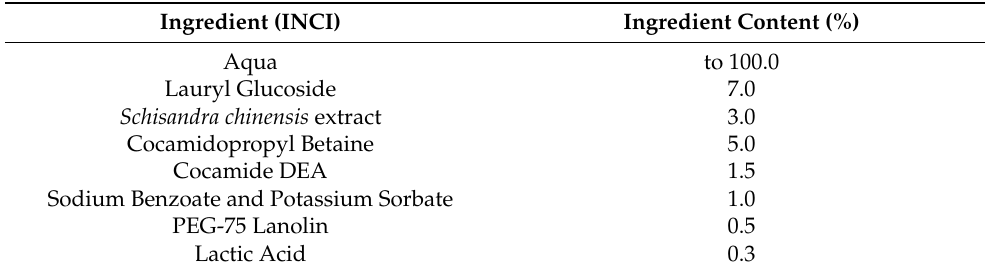
Table 4. Formulation of model body wash